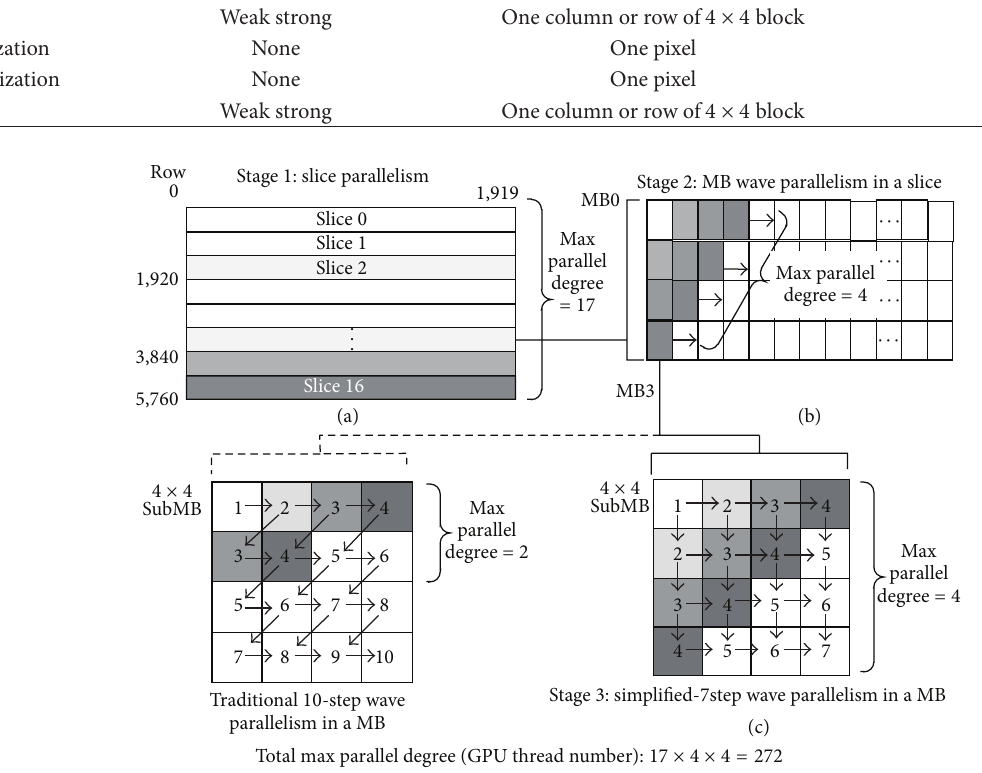
Figure 7: Multiple levels of parallelism of